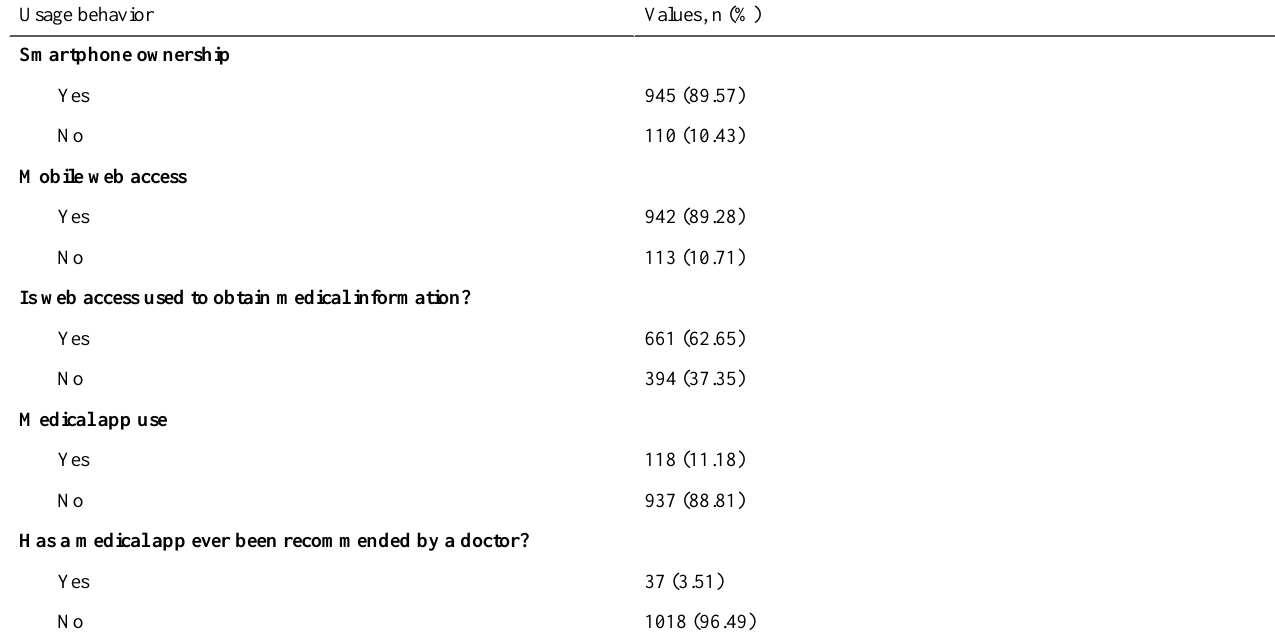
Table 1. Key data on smartphone and medical app usage behavior of the patients in this study